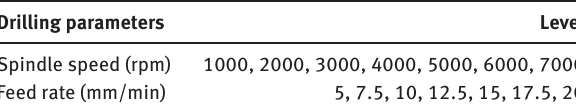
Table 3: Drilling parameters. Drilling